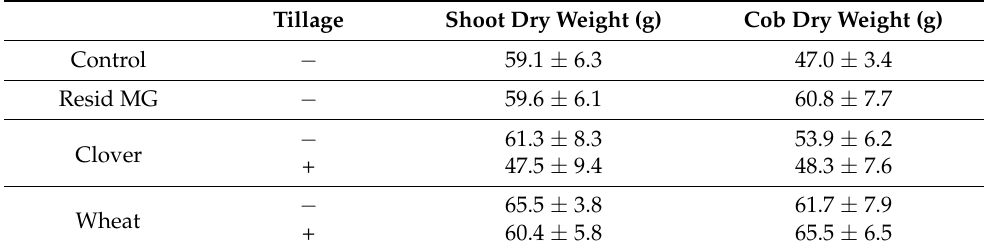
Table 4. The 2019 soil microbiome integrity experiment—dry weight parameters at 77 DAS 1 .